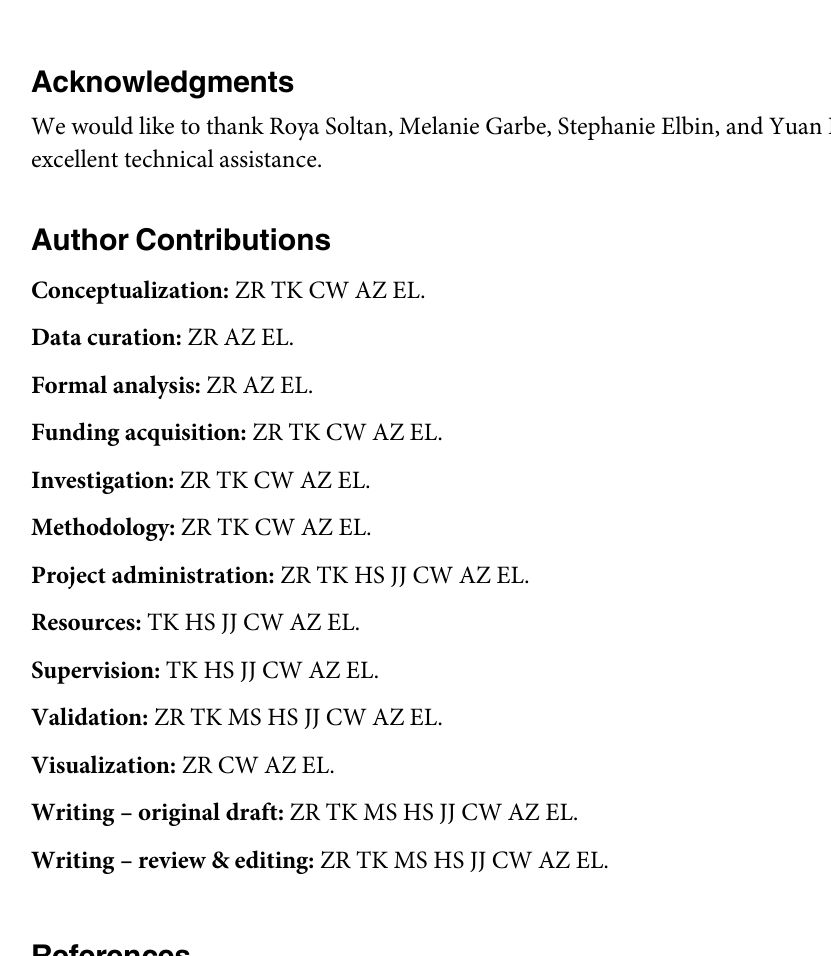
S1 Table. The original raw data table. The original raw data table (in a Excel spreadsheet) that were used to generate our bar graphs. (XLSX)